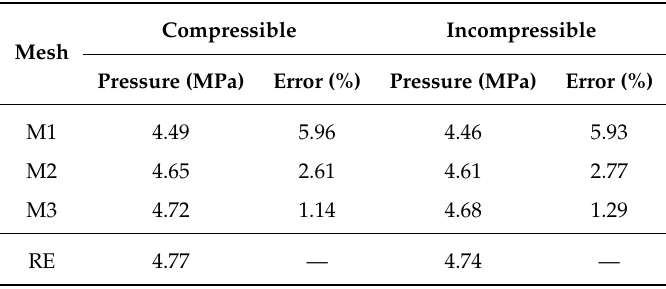
Table 7. Pressure values at the center of the channel inlet boundary patch, for both incompressible and compressible formulations and all levels of mesh refinement, Richardson’s extrapolation value (RE), and the relative